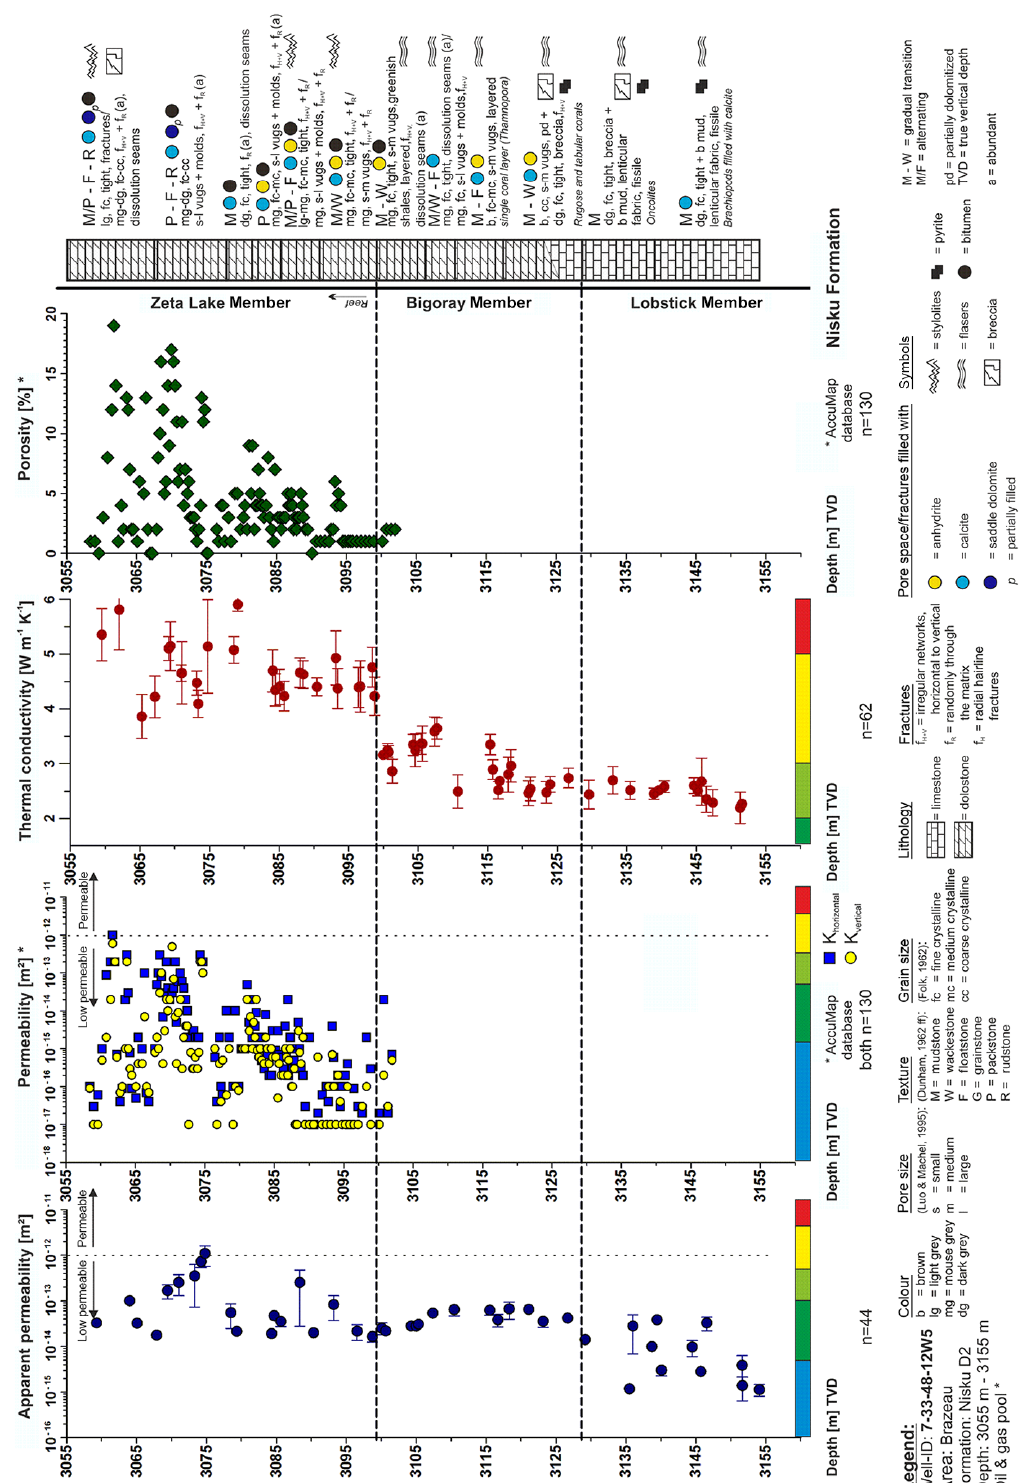
Figure 9. Rock properties of well 7-33-48-12W5 (Nisku Formation). Apparent permeability and thermal conductivity are displayed as arithmetic mean values with standard deviation. Permeability and porosity values were retrieved from the AccuMap database (marked with * hereafter). N represents the number of analyzed core